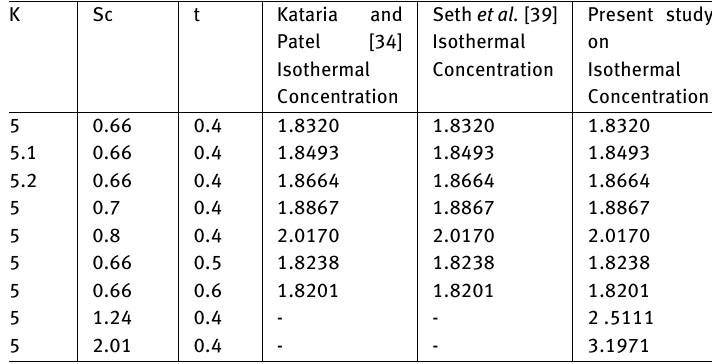
Table 2: Comparison of the current model’s Sherwood number with the findings in the literature of [34] and [39] K